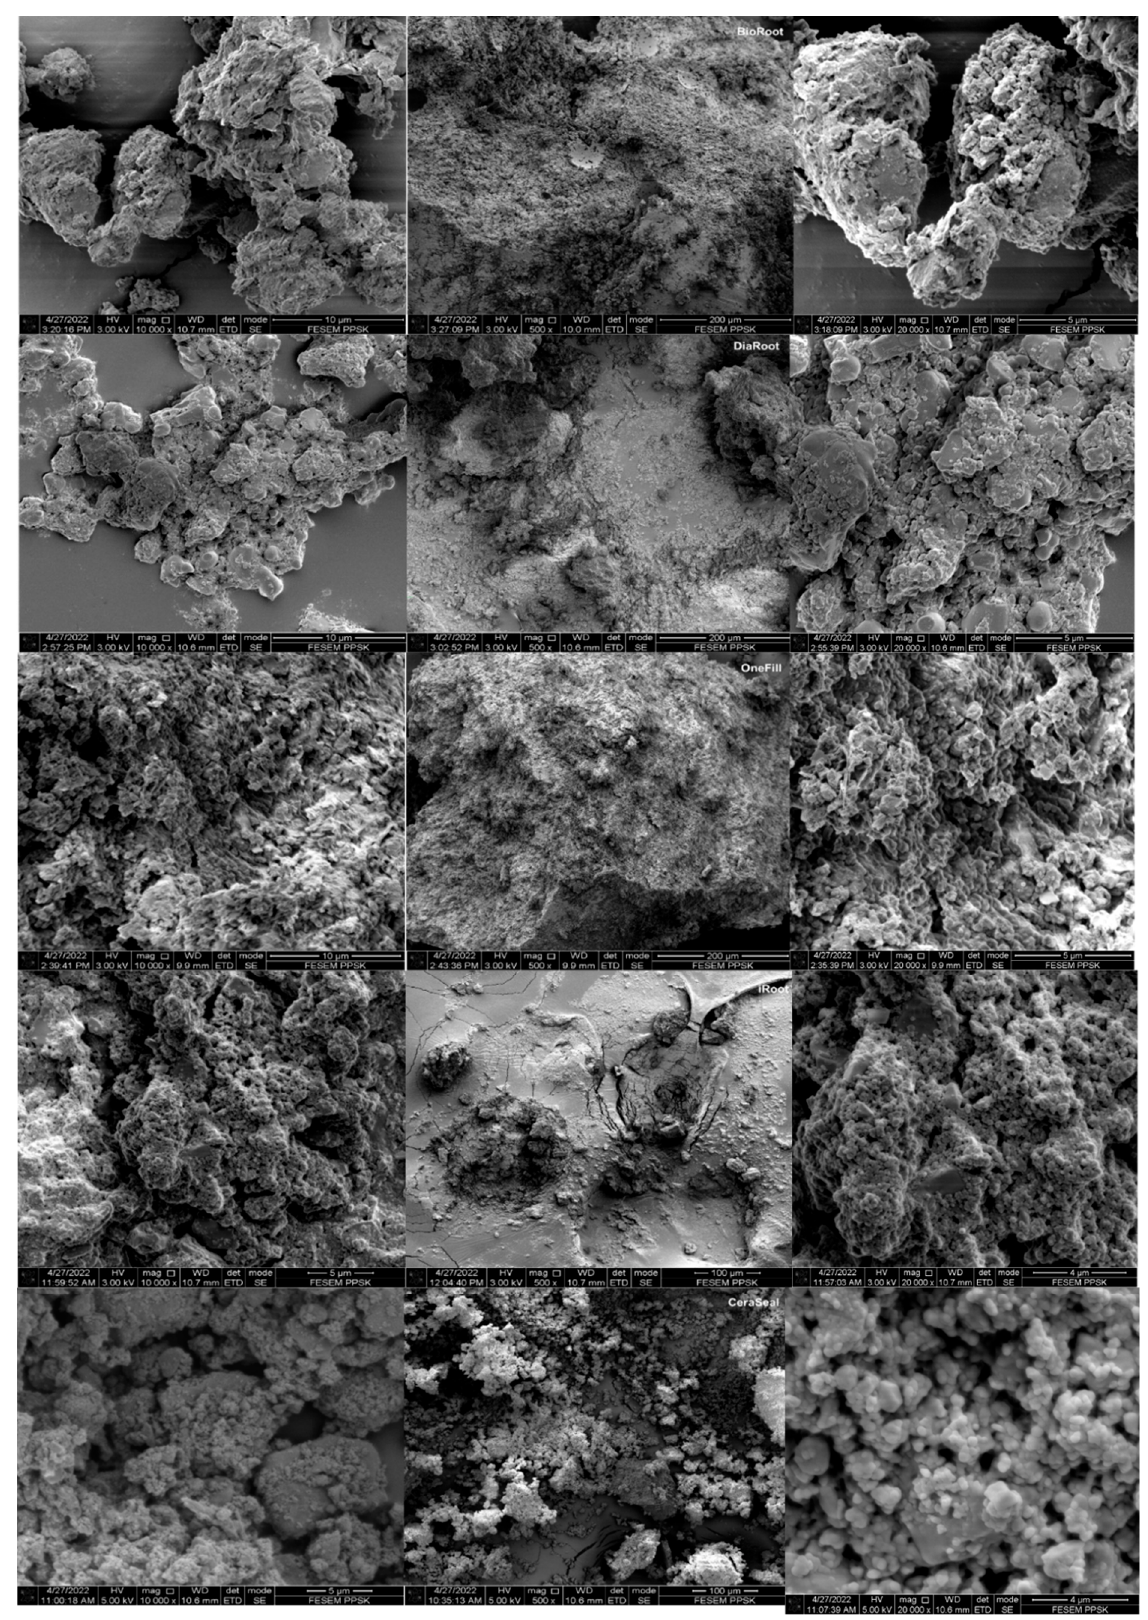
Figure 3. Scanning electron micrographs of root canal sealers at 5000×, 10,000×, and 20,000× magni- fication.